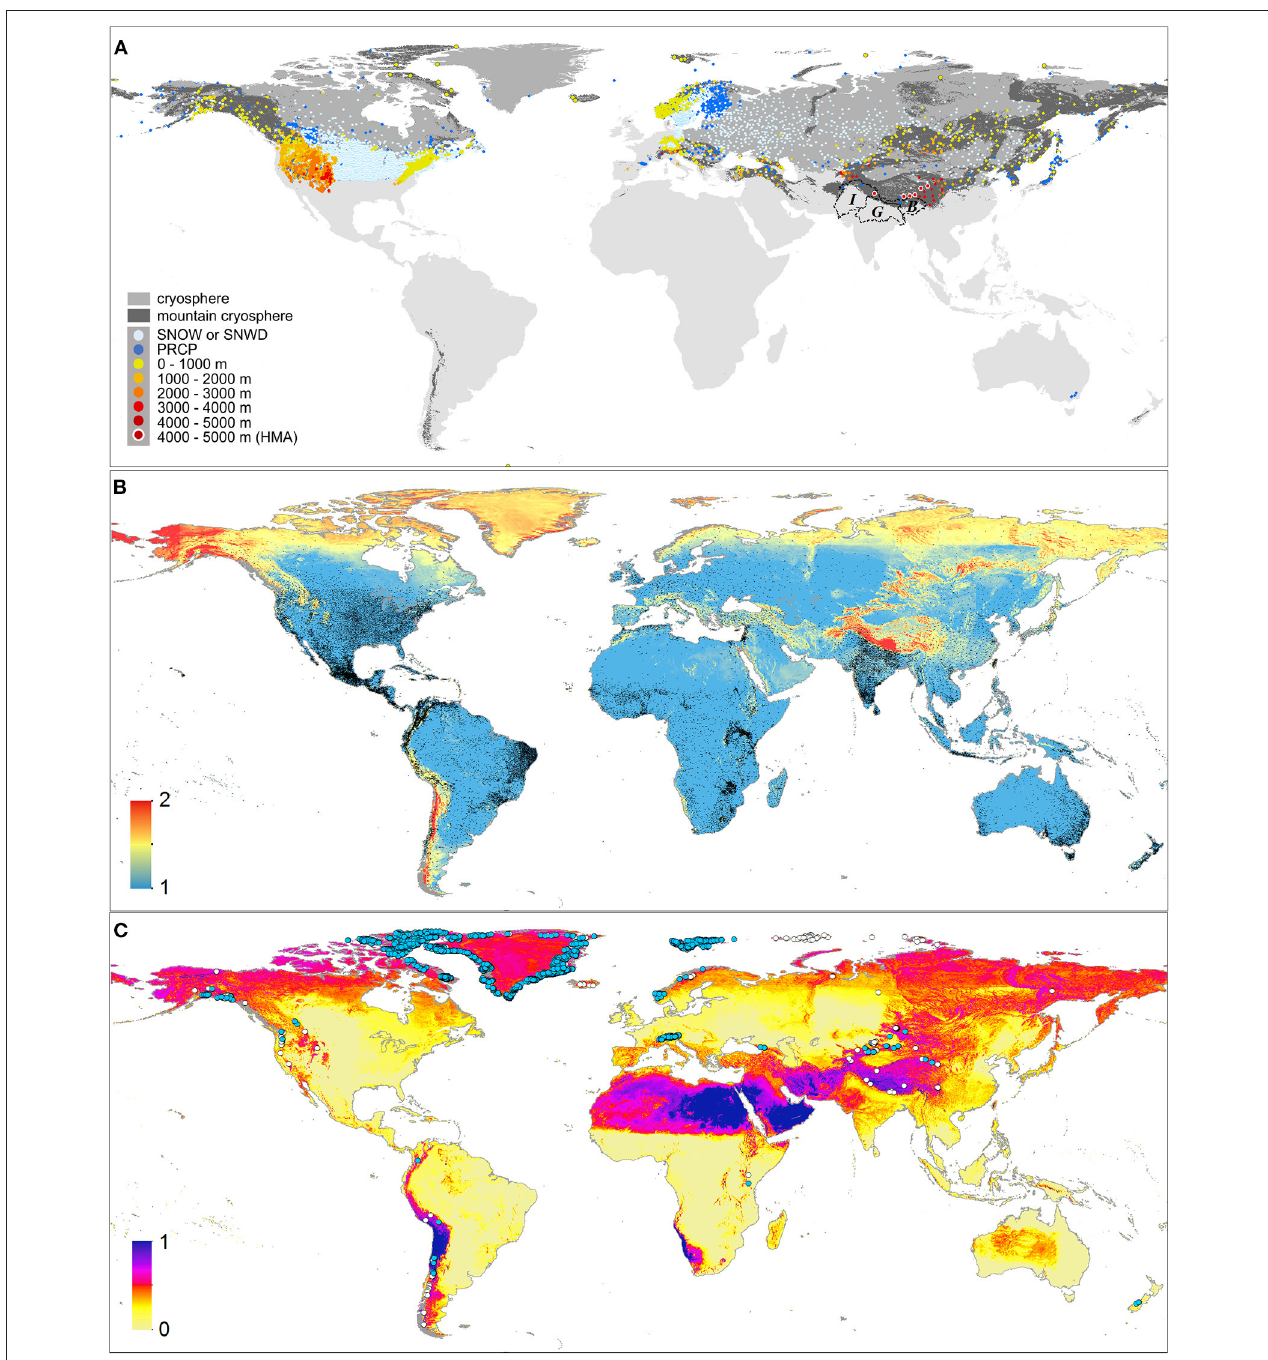
FIGURE 2 | (A) Weather stations (coloured dots) in the Global Historical Climate Network that lie within the terrestrial cryosphere (mid grey), or more specifically within the mountain cryosphere (dark grey) and whose daily observations are ongoing (in 2020/21). Light blue dots show stations in the lowland terrestrial cryosphere that report either snowfall water content (SNOW) or depth (SNWD). Dark blue dots show stations that reported precipitation (PRCP) but do not distinguish snow observations. Yellow to red dots show stations within the mountain cryosphere that report SNOW or SNWD, coloured according to altitude. Black polygons show the river basins of the Indus ( I ), Ganges ( G ), and Brahmaputra ( B ). The cryosphere is defined as having a mean monthly temperature < 0 ◦ C in January and/or July. The mountain cryosphere is the intersection between these areas and mountain areas (Karagulle et al., 2017). This highlights the paucity of snow observations in much of the mountain and Arctic cryosphere. (B) Bias-correction factors (blue-to-red scale, after Beck et al., 2020) that must be applied to the observation-based “WorldClim v2” annual climatological precipitation product (Fick and Hijmans, 2017) in order to agree with observations and models of catchment hydrology. All WorldClim v2 weather stations that reported precipitation (RAINID) in the 1970–2000 period are shown by black dots. (C) The uncertainty range in the estimated bias correction factors in 2b (the upper bound of the factor minus the lower bound) (after Beck et al., 2020), and glaciers with a reported average thickness only (white dots) or thickness-profile data (blue dots) ( GlaThiDa Consortium, 2020, accessed February